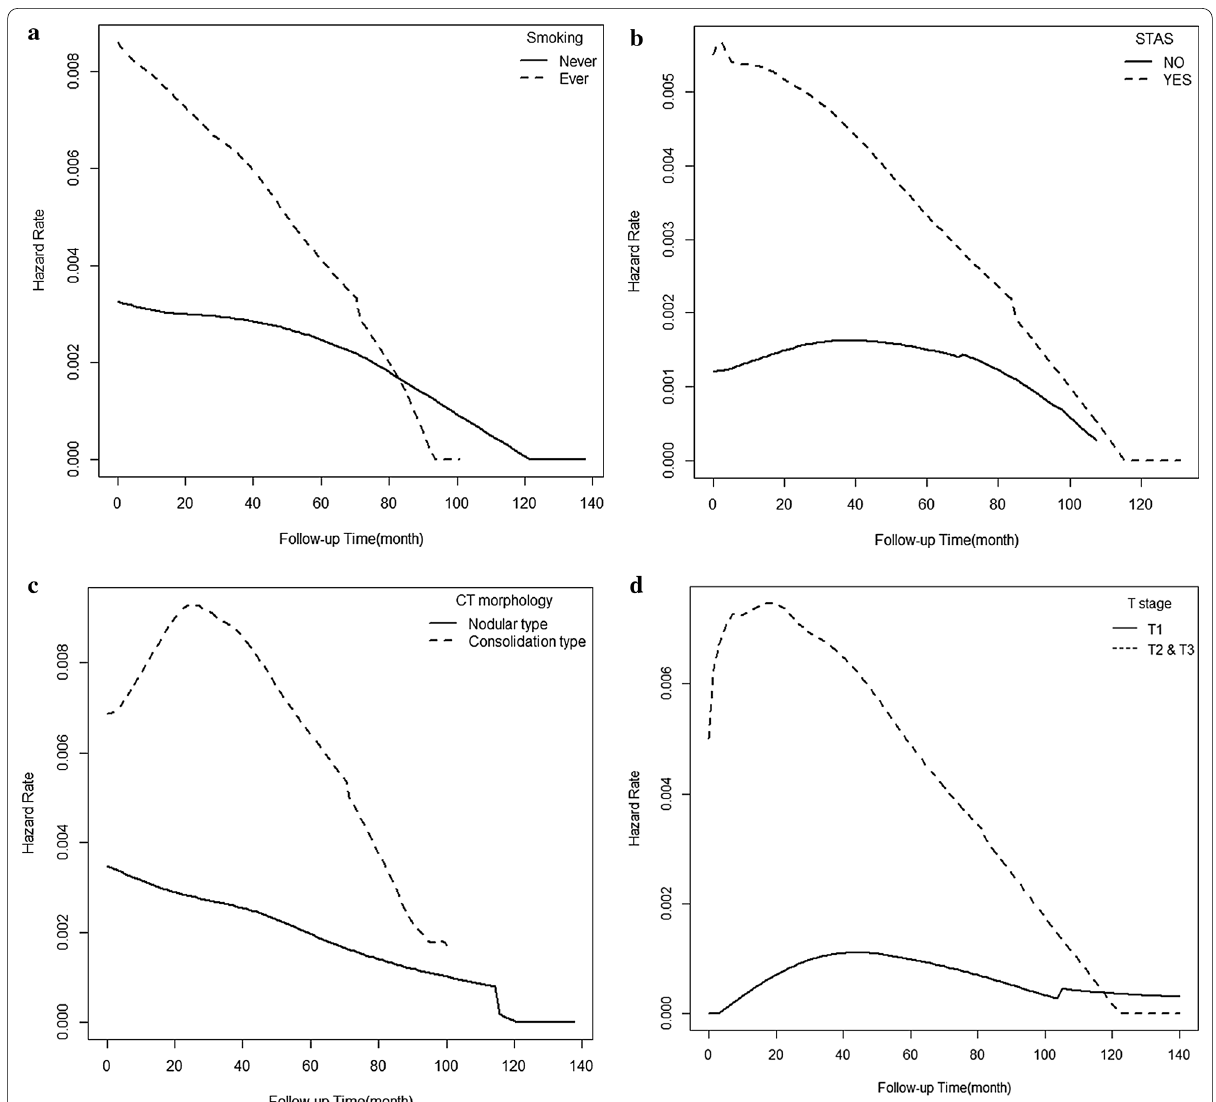
Fig. 3 Comparison of the death hazard rate according to smoking ( a ), STAS ( b ), consolidative CT morphology ( c ), higher T stage ( d ), higher N stage ( e ), and recurrence subtype ( f ) in patients with invasive mucinous